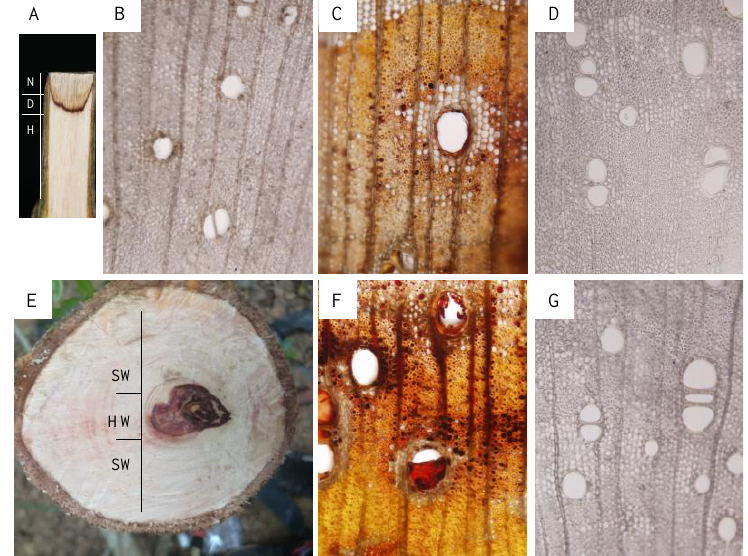
Figure 1. Histological observation of pruning-induced and naturally-produced heartwood samples of Dalbergia odorifera . ( A ) tangential section of a five-year-old D. odorifera sapling showing pruning-induced discoloration; ( B – D ) light microscope images of the transverse sections of the necrotic (N), discolored ( D ), and healthy (H) zones, respectively; ( E ) transverse section of a stem of 24-year-old D. odorifera tree showing natural heartwood (HW); ( F ) transverse section of natural heartwood; ( G ) transverse section of sapwood (SW).